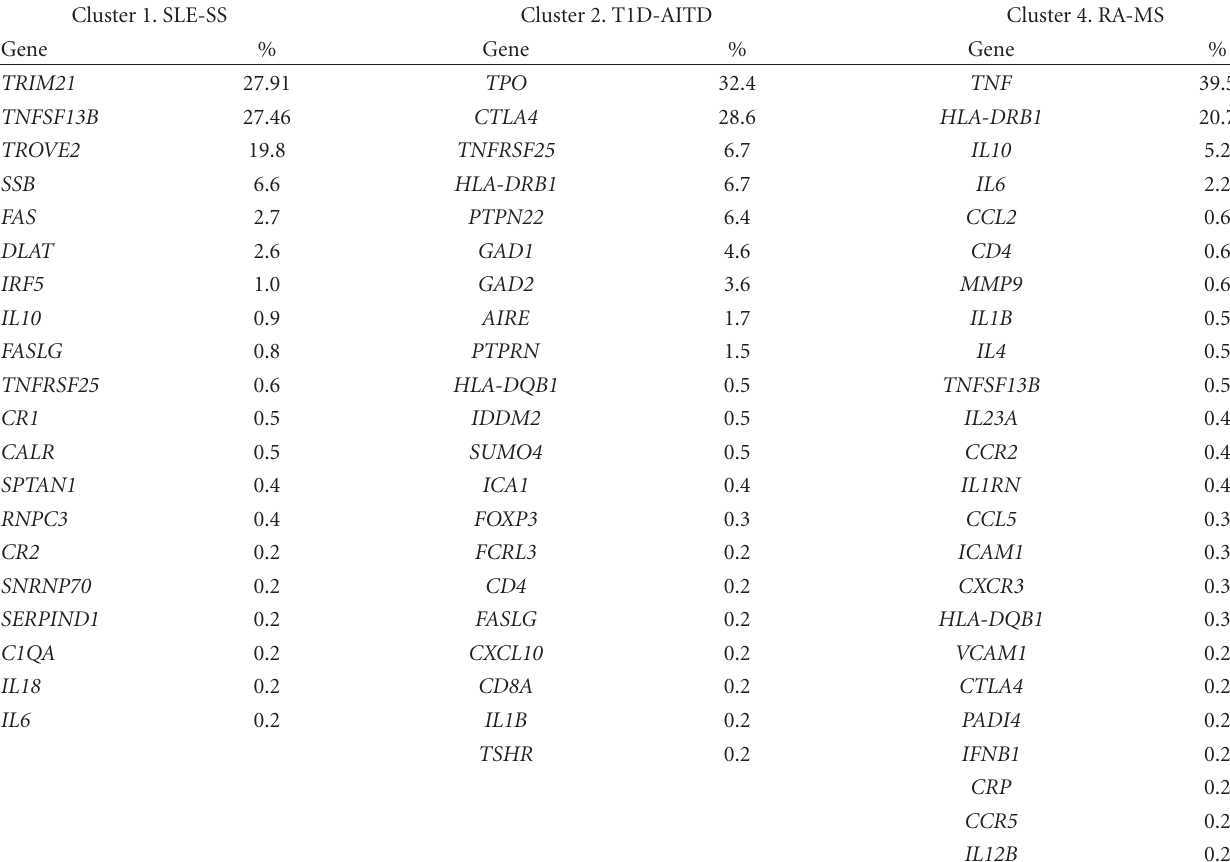
Table 3: Genes with a contribution higher than 0.1% to the found clusters of the studied autoimmune